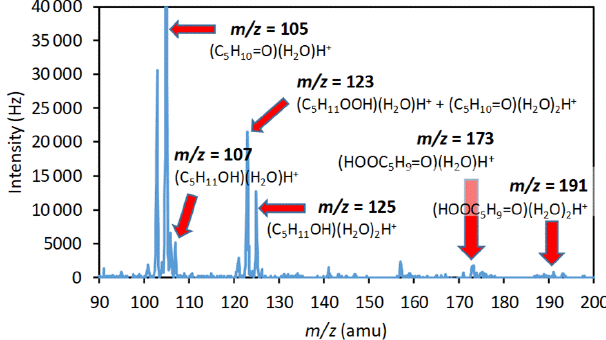
Figure 9. Main product peaks in the 1-pentylperoxy system (exper- iments from 8 November 2018). See Fig. 10 for Lewis structures of the molecules (without complexed H 2 O): m/z = 105 is C 5 H 10 =O; m/z = 107 is C 5 H 11 OH; m/z = 123 is mostly C 5 H 11 OH with some contribution of C 5 H 10 =O; m/z = 125 is C 5 H 11 OH; m/z = 173 and m/z = 191 are HOOC 5 H 9